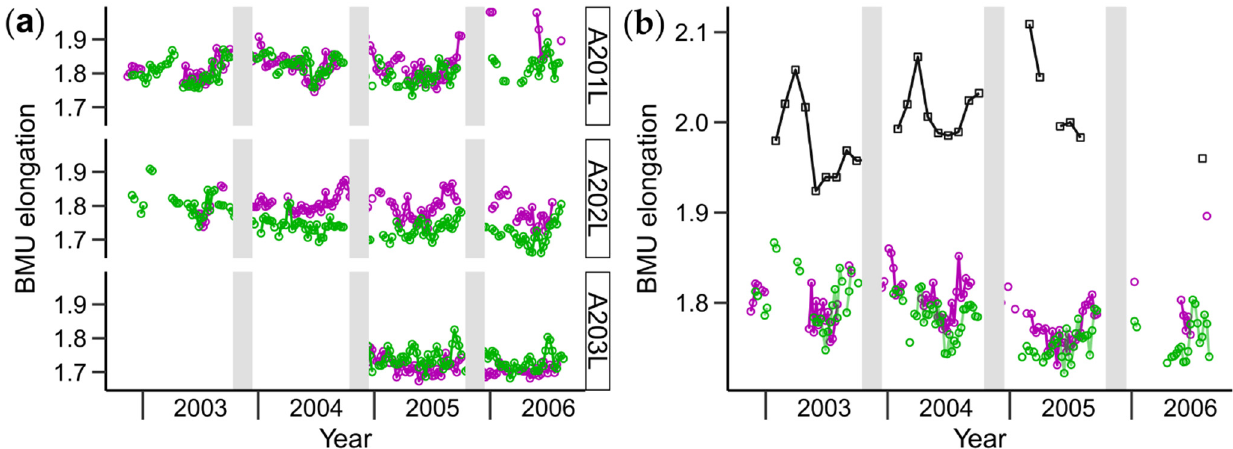
Figure 5. Average biomineral unit (BMU) elongation chronologies of the three studied shells (A201L, A202L and A203L) of Arctica islandica . Acronyms and color coding as in caption of Figure 3. Note, magenta = homogenous microstructure (oOSL); green = crossed-acicular microstructure (iOSL). Vertical gray bars = annual growth lines. ( a ) BMU elongation chronologies of each specimen and sublayer of the outer shell layer (oOSL, iOSL). ( b ) Average BMU elongation chronologies computed from the curves depicted in ( a ). Data from the ventral margin are weekly resolved. Monthly Sr/Ca data of the hinge (data from all studied specimens combined) are shown for comparison.